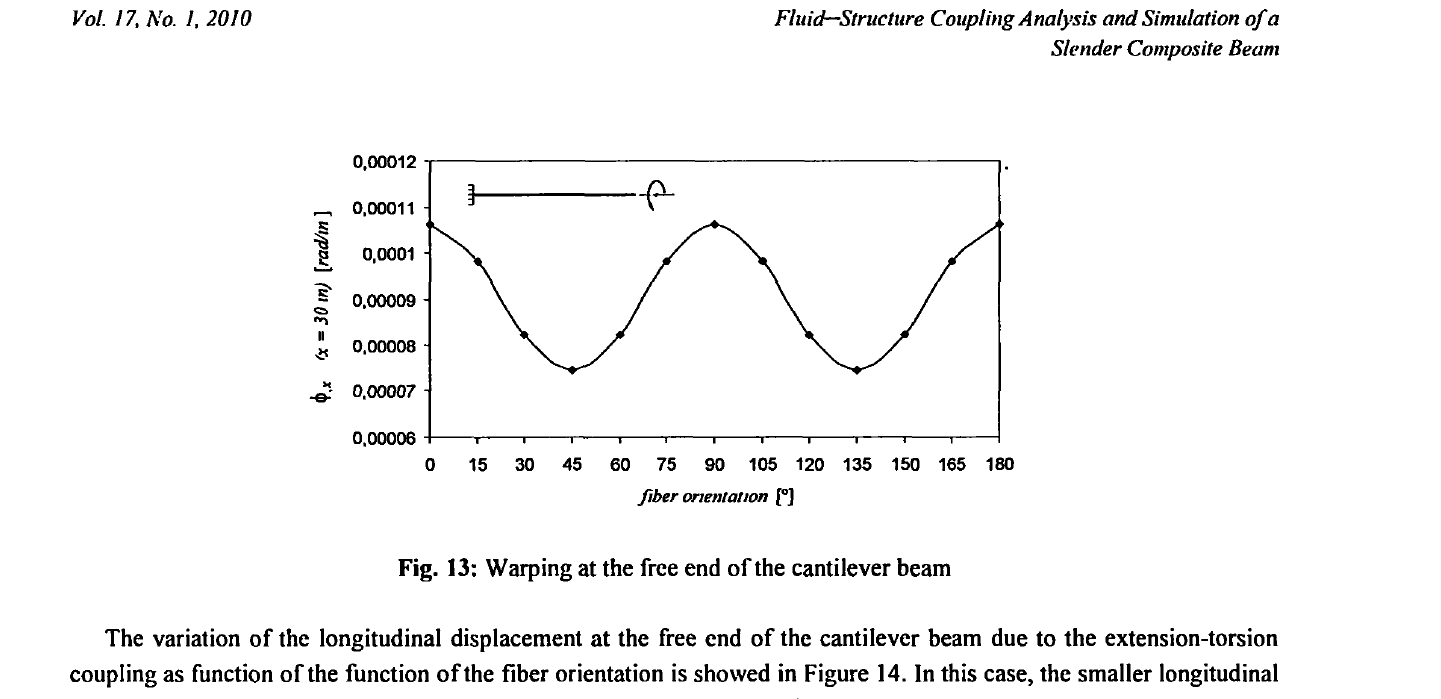
Fig. 13: Warping at the free end of the cantilever beam